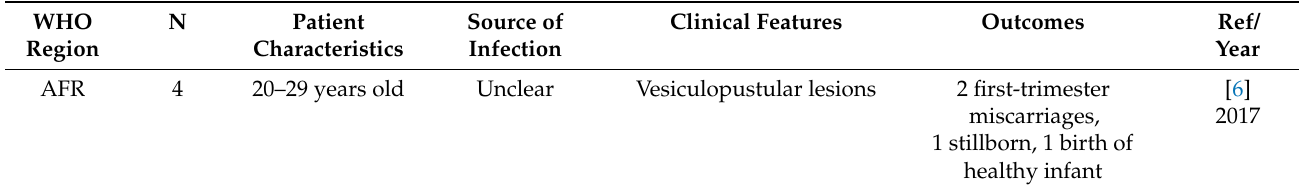
Table 4. Pregnancy-related monkeypox virus infection in